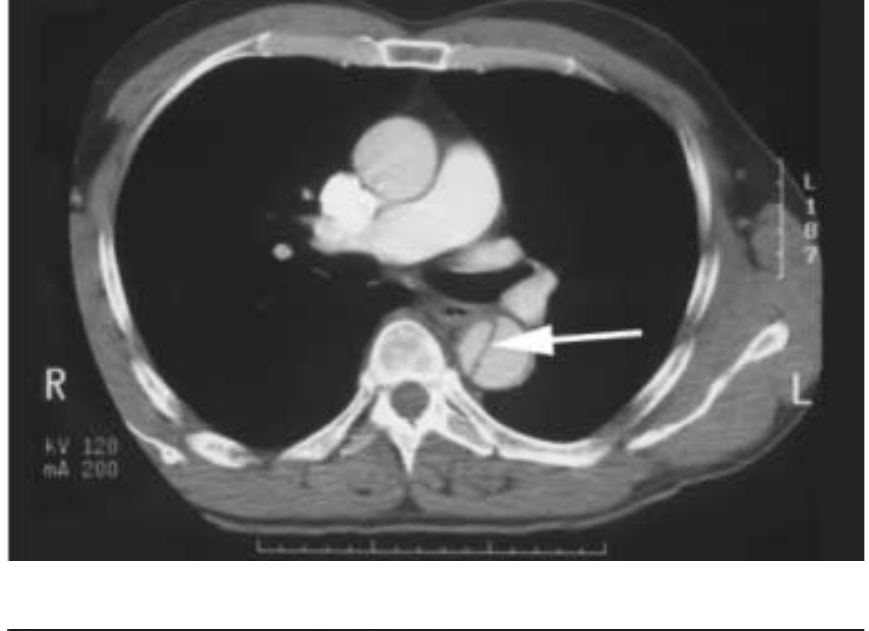
Successful stenting of the